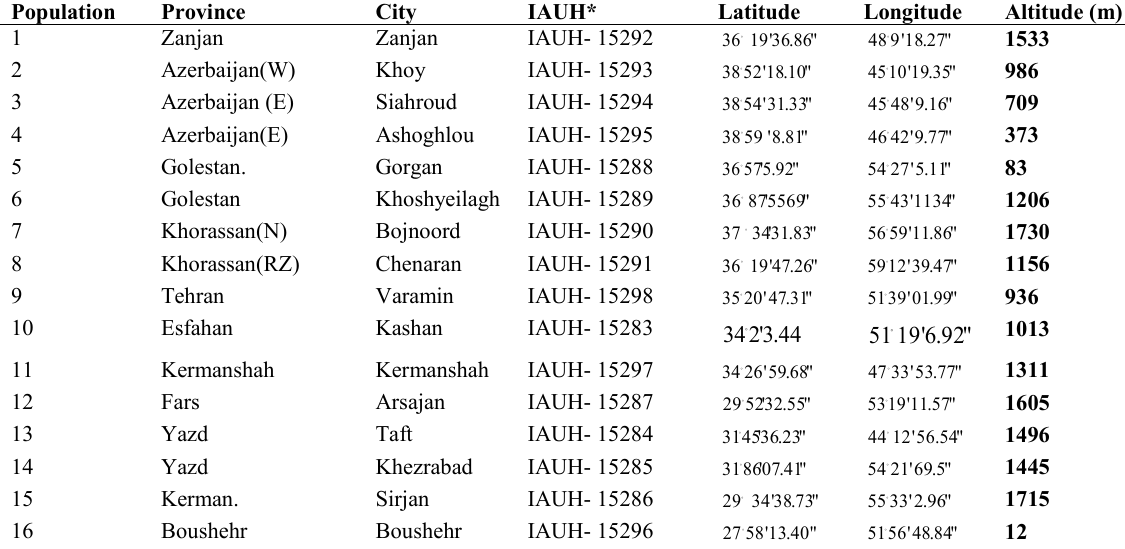
Table 1. Geographical features of the investigated populations.